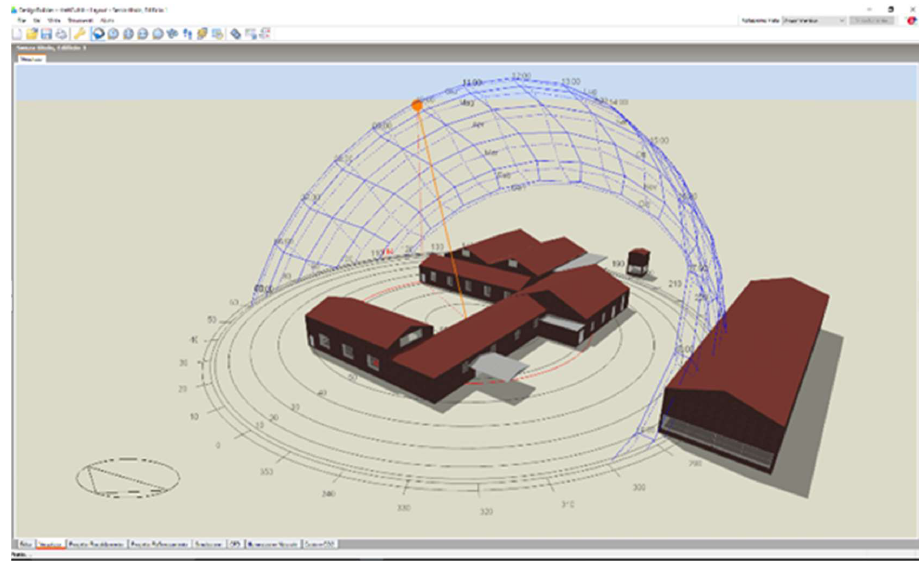
Figure 8. Model of the building examined with the energy simulation software program Design Builder.